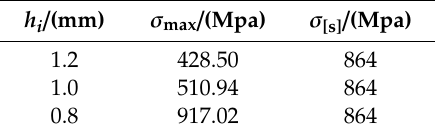
Table 4. The maximum equivalent stress with di ff erent